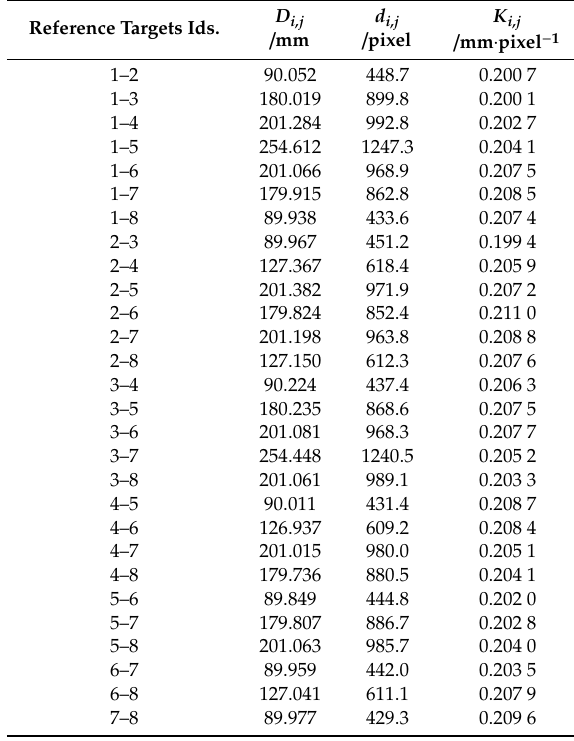
Table A2. Sample of calculated scale coe ffi cients related to referential B. Reference Targets